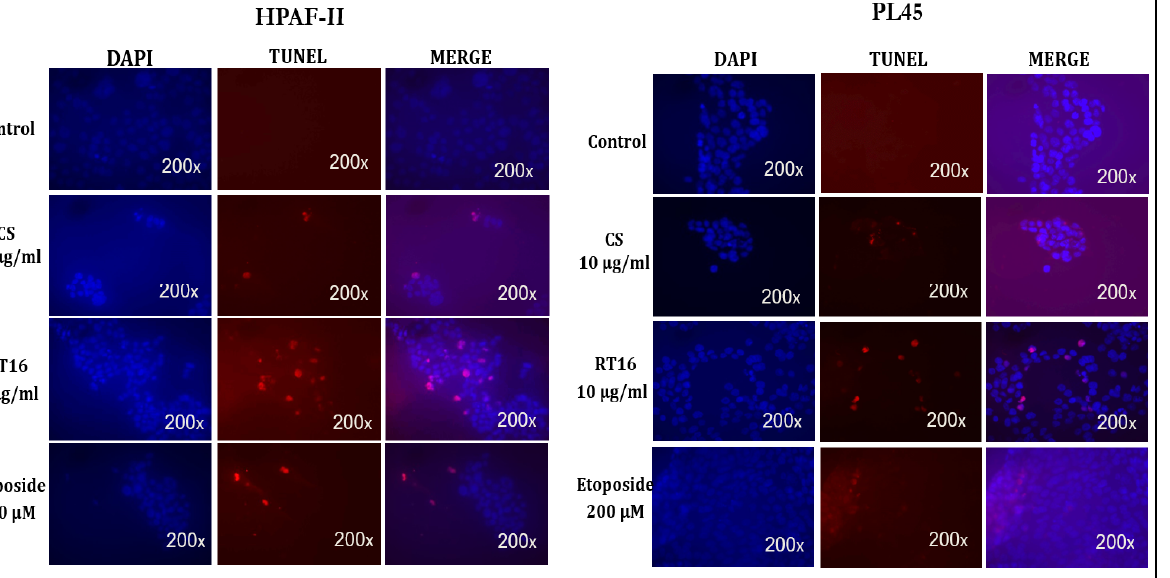
Figure 7. TUNEL and DAPI staining for apoptosis detection in HPAF-II and PL45 cells. A total of 3 × 10 4 cells were seeded on chamber slides (Nunc, Denmark). After 24 h, the cells were treated with RT16 or CS extract for 4 h at a concentration of 10 μ g/mL. At the end of the treatment, the cells were stained with TUNEL (Roche Applied Science, Mannheim, Germany) and DAPI (Vector la- boratories Inc., Burlingame, CA, USA) and analyzed under fluorescent microcopy (×200 magnifi- cation).